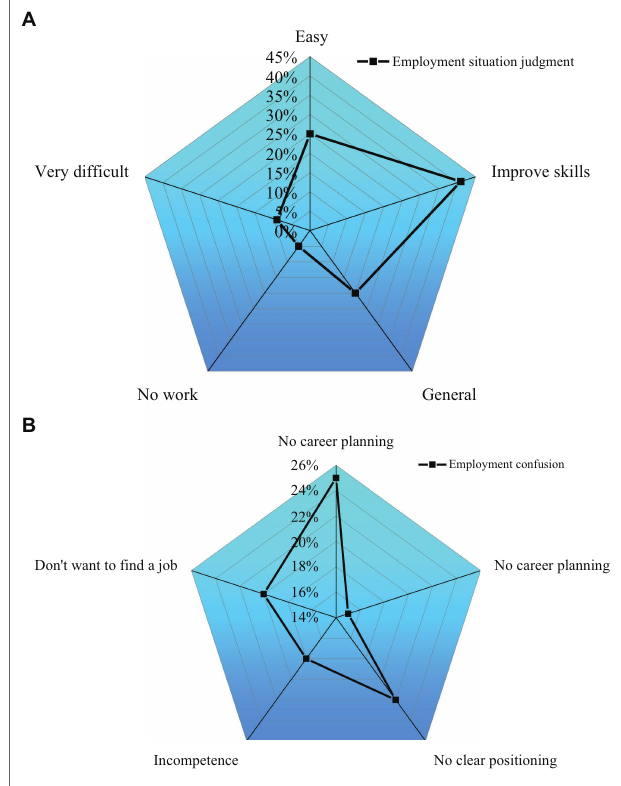
FIGURE 14 | Research funds and projects. (A) Evaluation of the situation of innovation and entrepreneurship and (B) employment confusion.